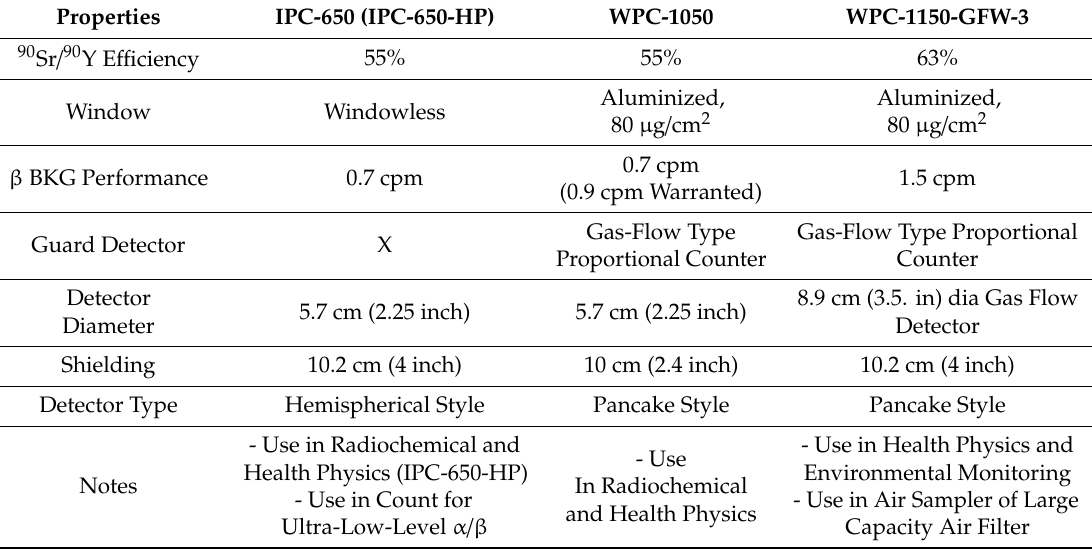
Figure 7. Gas-flow type proportional counter: ( a ) IPC-650, ( b ) WPC-1150, ( c ) WPC-1150-GFW [70,71]. Table 6. Compared properties by the Ortec automatic count system.